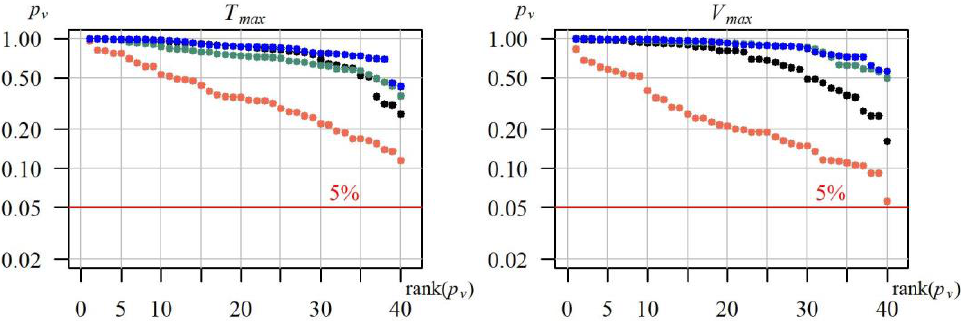
Figure 9. Distribution of descending p v -values of the Anderson – Darling goodness-of-fit test of four tested probability distributions ( ● normal, ● lognormal, ● Weibull, ● gamma) of the duriation T max and volume V max of the maximum drought, in 40 gauging cross-sections.